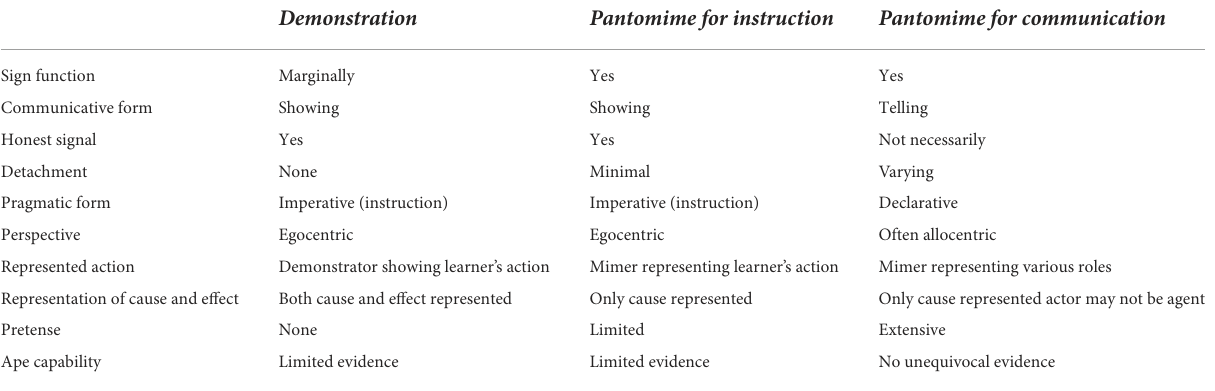
TABLE 1 Ten factors distinguishing demonstration, pantomime for instruction, and pantomime for